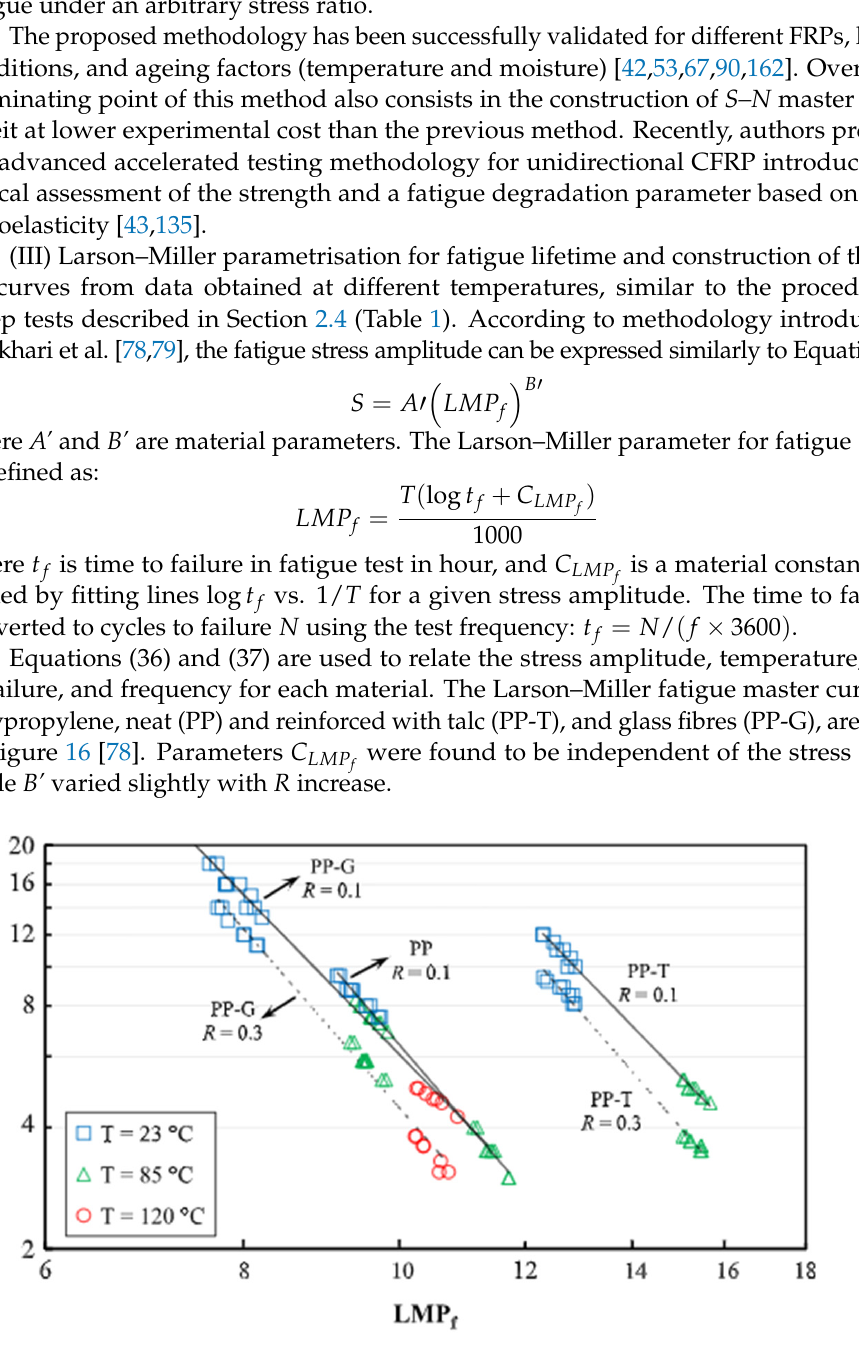
Figure 16. Larson–Miller master curves for polypropylene (PP), neat and reinforced with talc (PP-T), and glass fibres (PP-G) at R = 0.1 and 0.3. Adapted with permission from Ref. [78]. Copyright 2016 Elsevier.